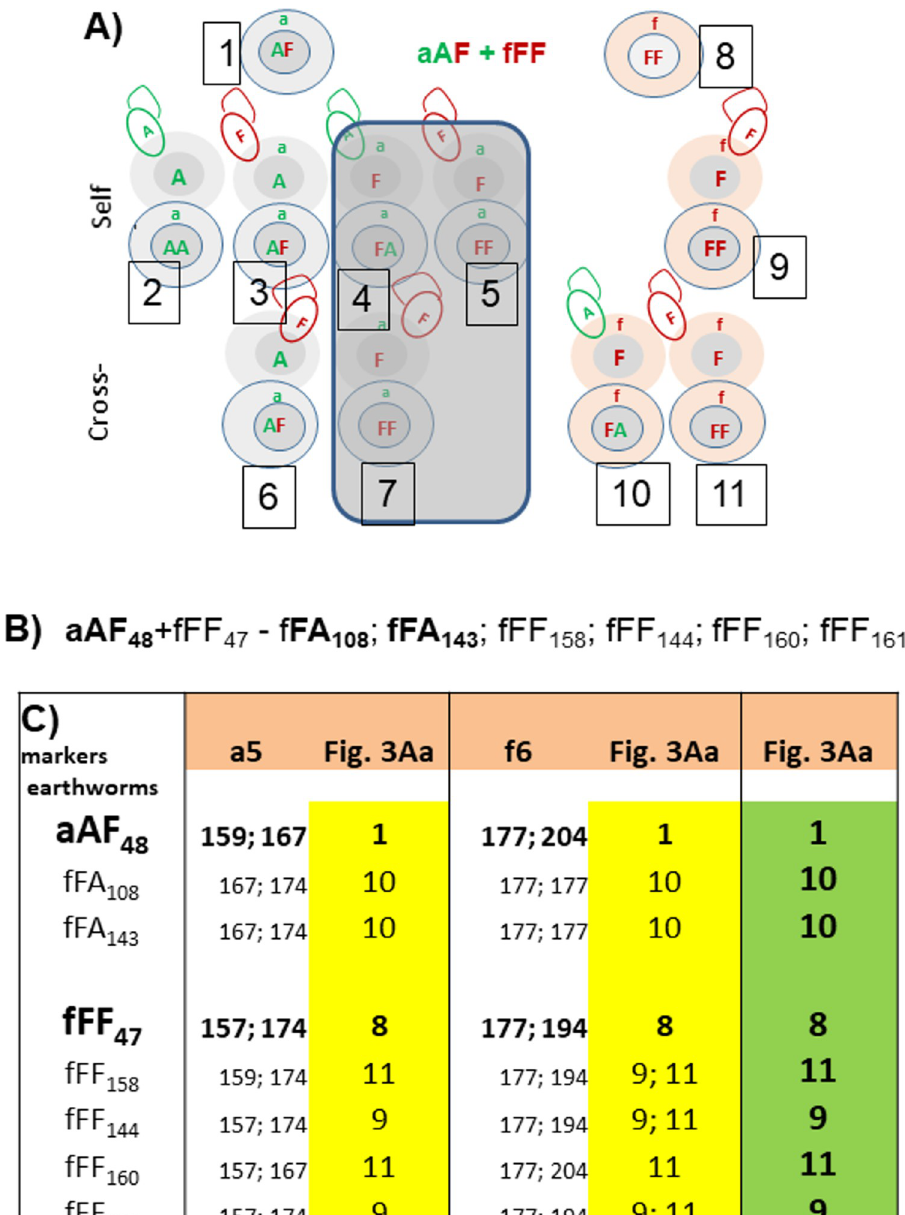
Fig 3. Considerations on the results of mating the aAF hybrid with fFF parental specimen. (A) Back-cross of aAF +fFF pair; symbols as on Fig 1. (B) Offspring of aAF+fFF pair (the example from [7]. (C) Allele sizes of a5 and f6 microsatellite markers in particular specimens from the above family and putative identification with genotypes numbered 1–11 on Fig 3A (in yellow for particular markers and in green as most probable). Offspring of back-cross aAF+fFF. Among offspring of back-cross aAF+fFF (Fig 3A), cross-fertilized ova of aAF hybrids may give a new generation of aAF hybrids (6) and (unique) mitonuclearly-incompatible aFF specimens (number 7) very rare in our previous experiments [9] while cross-fertilized ‘fF’ ova of the fFF specimens can give fFA hybrids fertilized by ‘A’ spermatozoa from the aAF parent (number 10) and fFF specimens (number 11) fertilized by hybrid’s ‘F’ spermatozoa (Fig 3A). Such family is exemplified here by progeny of aAF48+fFF47